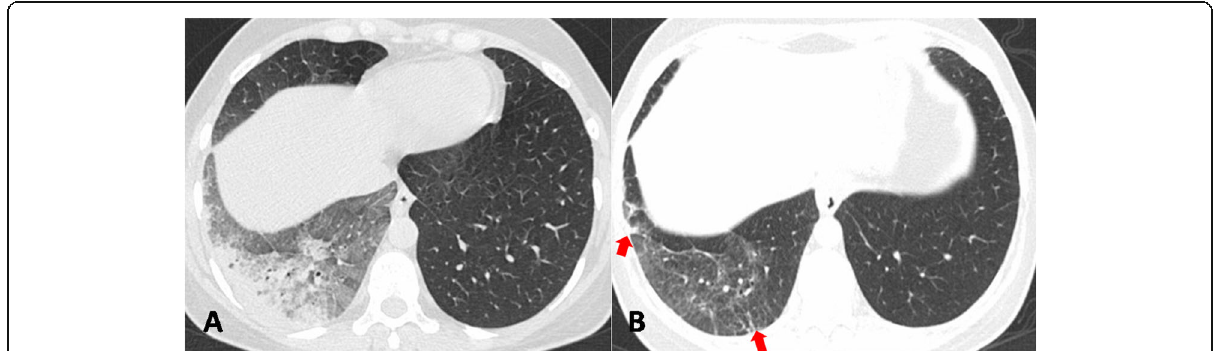
Fig. 3 Axial chest CT image in lung window settings of a 36-year-old COVID-19 patient showing a mixed GGO and consolidation in right lower